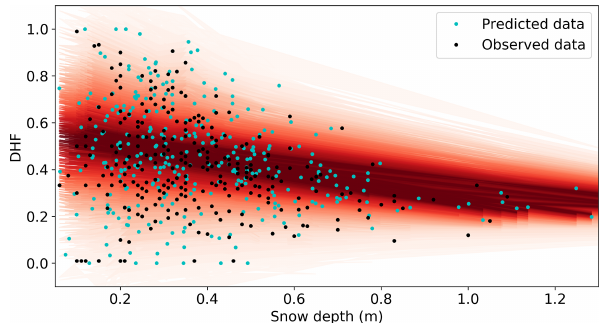
Figure 7. Prediction on DHF (cyan) using a GP fit trained on ob- served data (black). Snow depth is from samples from a log-normal distribution with parameters from Table 4. The GP fit is illustrated in red, where darker red represents a high posterior probability that follows the mean